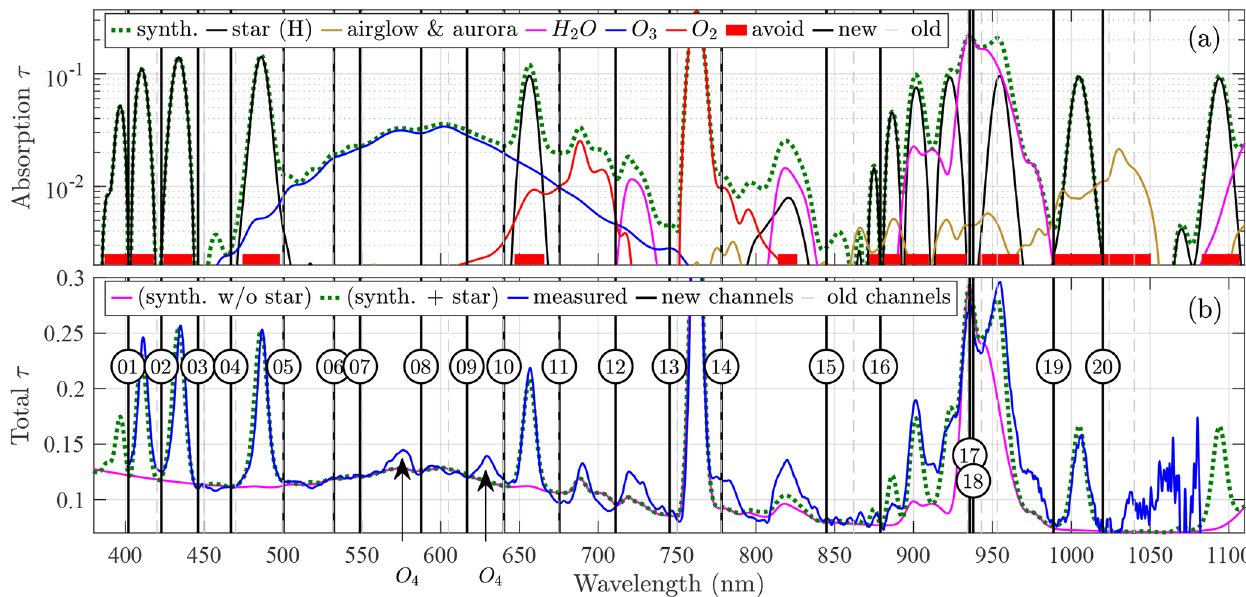
Figure 26. OD spectra of constituents that contaminate the retrieval of aerosol and cloud ODs in the visible and near-infrared. (a) Starpho- tometer channel selection (vertical black lines) obtained by avoiding contaminants, such as the stellar (Vega) absorption OD spectrum (black curve), OD errors associated with airglow and IBC2 aurora (gold curve) as well as O 2 (at least those parts of its red curve whose OD (cid:39) 0 . 01). The red bars delimit intervals where those contaminants are non-negligible ( τ > 0 . 007). The channel selection also includes strategically selected regions of H 2 O and O 3 absorption that allow for the dynamic identification and characterization of their OD and, subsequently, their removal from the total OD spectrum. The cumulative contaminant optical depth yields the total synthetic curve (green dotted curve). (b) The synthetic curve (with an added aerosol scattering component) versus an OD spectrum (blue curve) retrieved from Vega measurements over Eureka (measured on 3 November 2019 at 14:01:02UTC). The optimal fit shows generally good agreement except where the contaminant influence is misestimated. This is particularly true for O 4 absorption, which we realized, a posteriori, should have been included in the ensemble of contaminants. The numbers of the selected channels are superimposed for reference